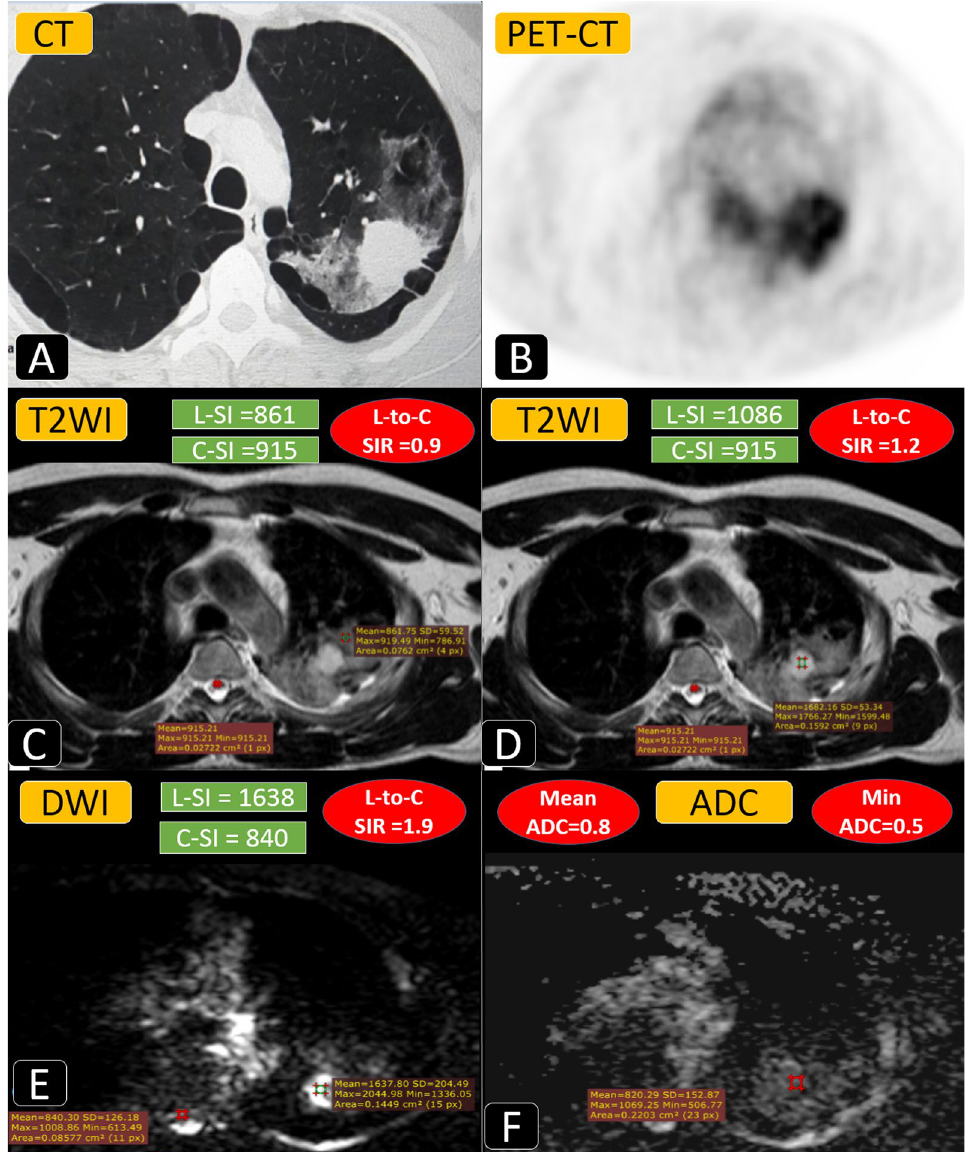
Fig. 2 A 50-year-old male patient complained of chronic cough and chest pain. A Axial chest CT cut (lung window) showed left upper lobar apical– posterior large sub-pleural homogeneous solid lung nodule showing two pleura tags and surrounded by parenchymal ground-glass reaction/halo; this is on a background of bilateral upper lobar para-septal emphysema. B Axial chest PET-CT image showing high 18F-FDG uptake. C Axial T2WI shows the high signal intensity of the nodule. After placing two ROIs within the nodule and the spinal cord, the lesion-to-spinal cord signal intensity ratio was calculated 0.9. D Same axial T2WI showing iso-intense signal of the surrounding lung parenchyma. After placing two ROIs within the = parenchyma around the lesion and the spinal cord, the lesion-to-spinal cord signal intensity ratio was calculated 1.2. E Axial DWI showing bright = signal of restricted diffusion and lesion-to-spinal cord signal intensity ratio was calculated 1.9. F ADC mapping images showing low signal = intensity with minimum ADC 0.5 10 − 3 mm 2 /s and mean ADC 0.8 10 − 3 mm 2 /s. Referring to the estimated cutoff values, T2WI L-to-SC SI ratio, = × = × DWI L-to-SC SI ratio, minimum ADC, and mean ADC suggested a malignant process. Pathologically proven non-small cell lung cancer